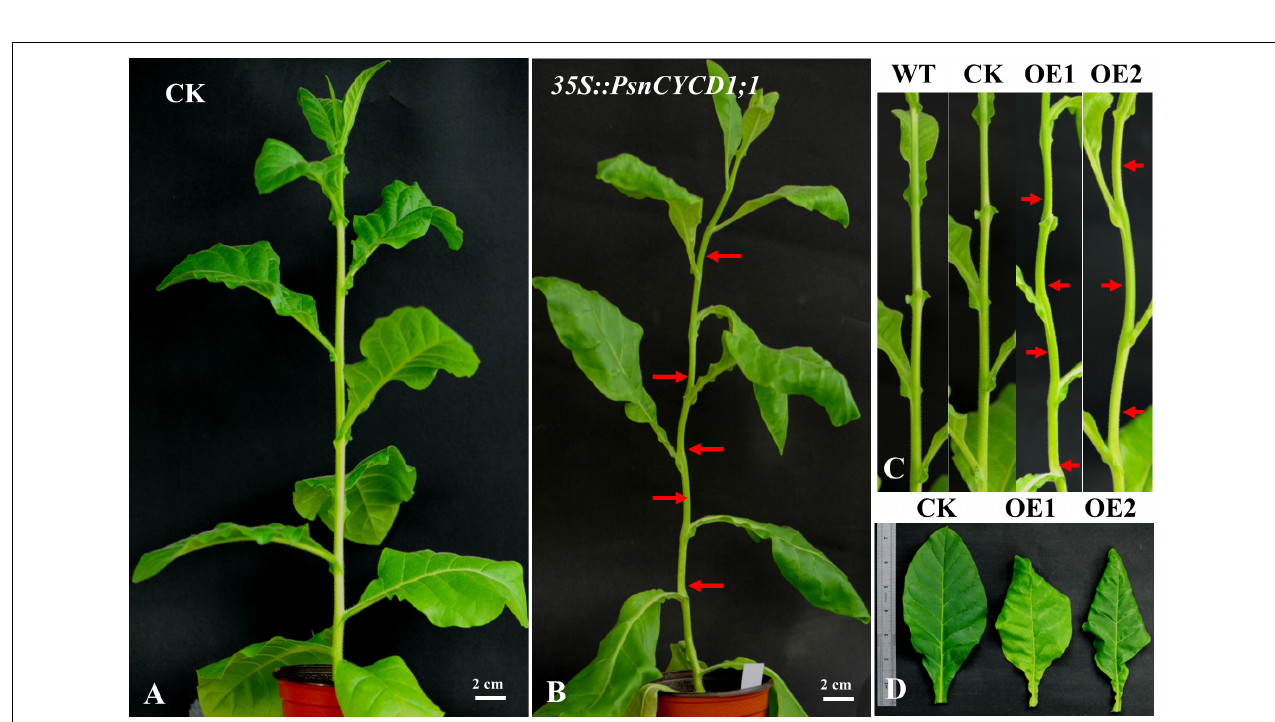
FIGURE 3 | Phenotype observation of empty vector control (CK) and 35S:PsnCYCD1;1-GFP tobacco. (A) Three-month old CK tobacco; (B) 3-month old 35S:PsnCYCD1;1-GFP transgenic tobacco; (C) stem morphology of transgenic, wild-type, and CK tobacco; and (D) comparison of leaf morphology between transgenic and CK tobacco; WT, wild-type; CK, empty vector control; OE1/2, two individual transgenic lines.